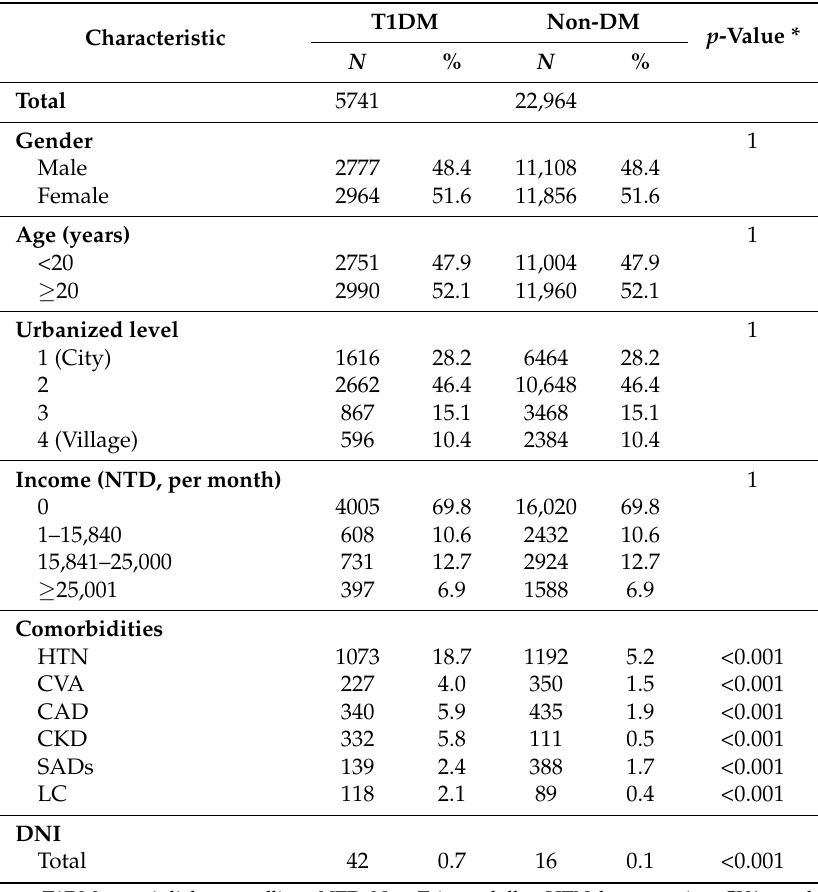
Table 1. Demographic characteristics of the T1DM and non-DM